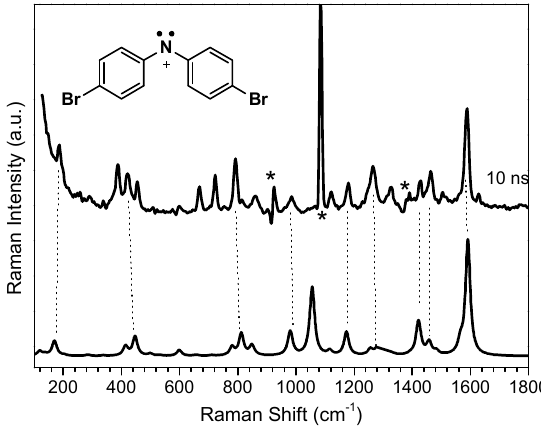
Figure 2. Comparison of the nanosecond time-resolved resonance Raman (ns-TR 3 ) 10 ns spectrum obtained after excitation of DN in MeCN (pump 266 nm, probe 416 nm) to the density functional theory (DFT) calculated normal Raman spectrum of 2 . The symbol * means features affected by solvent subtraction artifacts.